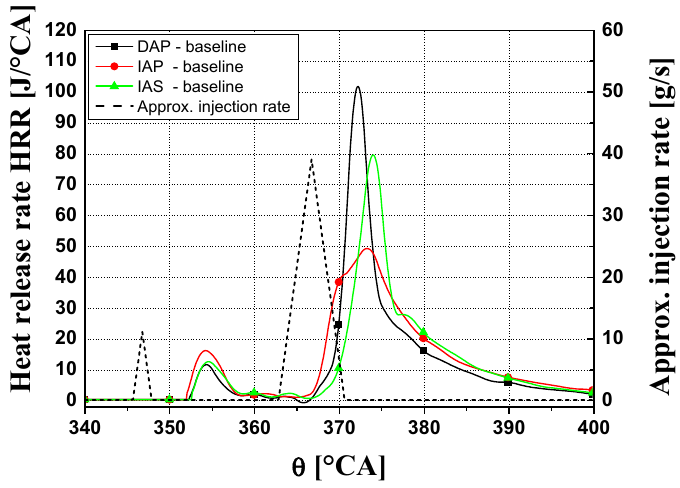
Figure 9. HRR traces of the reference calibrations, at 2000 × 5, for the three injector typologies under investigation.